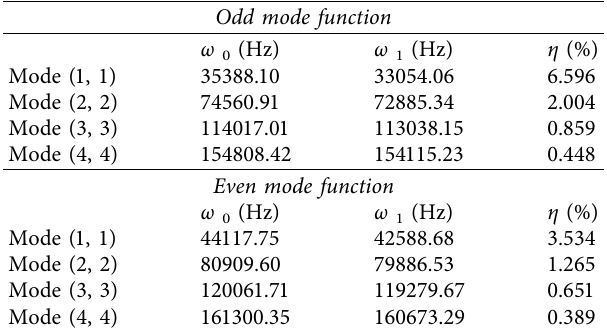
Table 3: Comparison of linear and nonlinear resonant frequencies for the first four